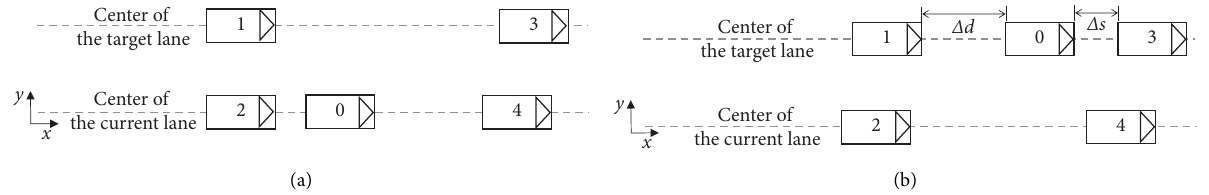
Figure 1: Vehicles involved in the lane change maneuver. (a) The initial state of the vehicles when vehicle 0 begins a lane change maneuver. (b) The final state of the vehicles when vehicle 0 finishes the change lane